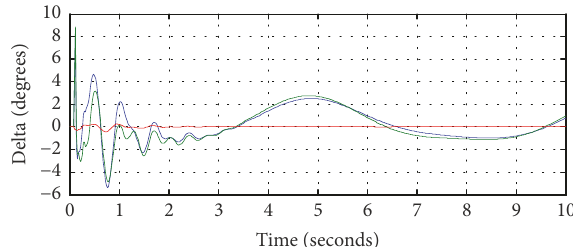
Figure 10: Actuator deflections in AOA tracking of a sinus signal.